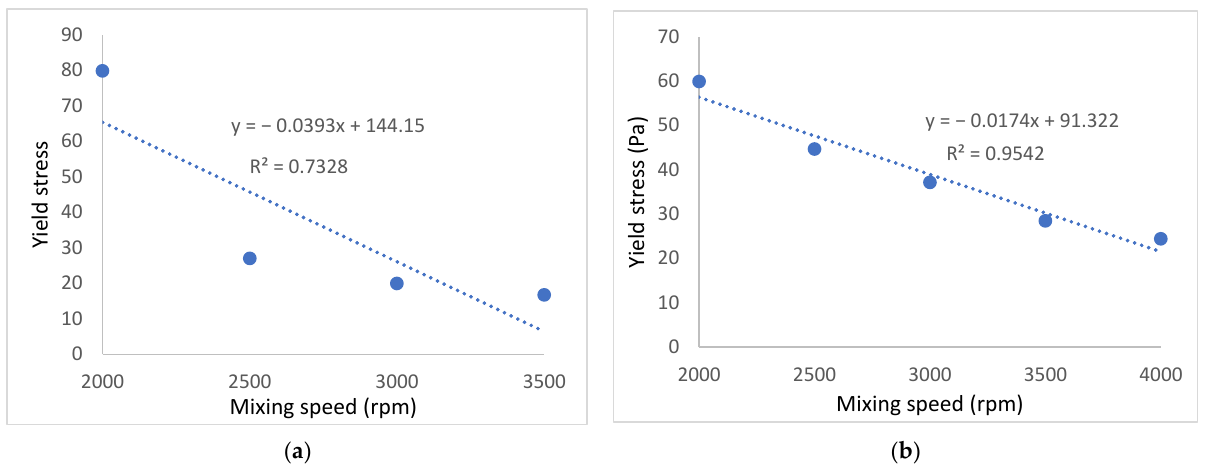
Figure 5. Yield stress of AS/FA samples formulated at varying shear mixing rates ( a )2000 rpm ( b ) 2500 rpm ( c ) 3000 rpm ( d ) 3500 rpm .